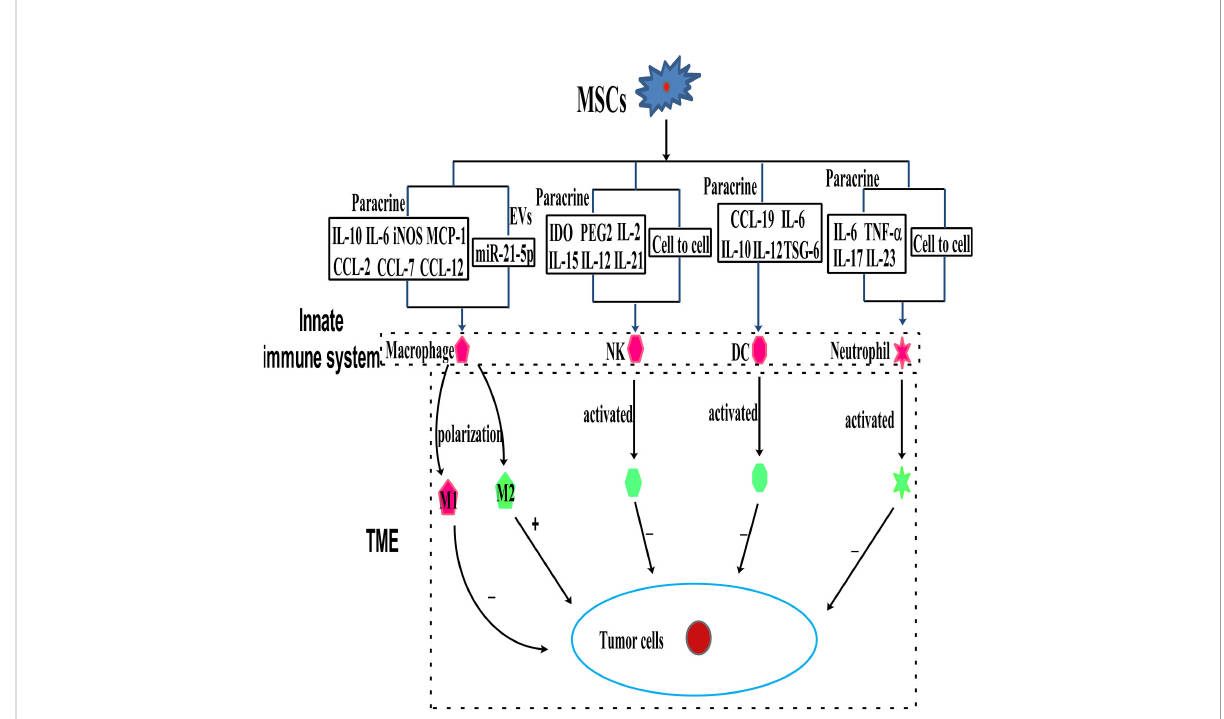
FIGURE 3 MSCs can modulate innate immune cells through the mechanism of paracrine cytokines, EVs, and cell to cell